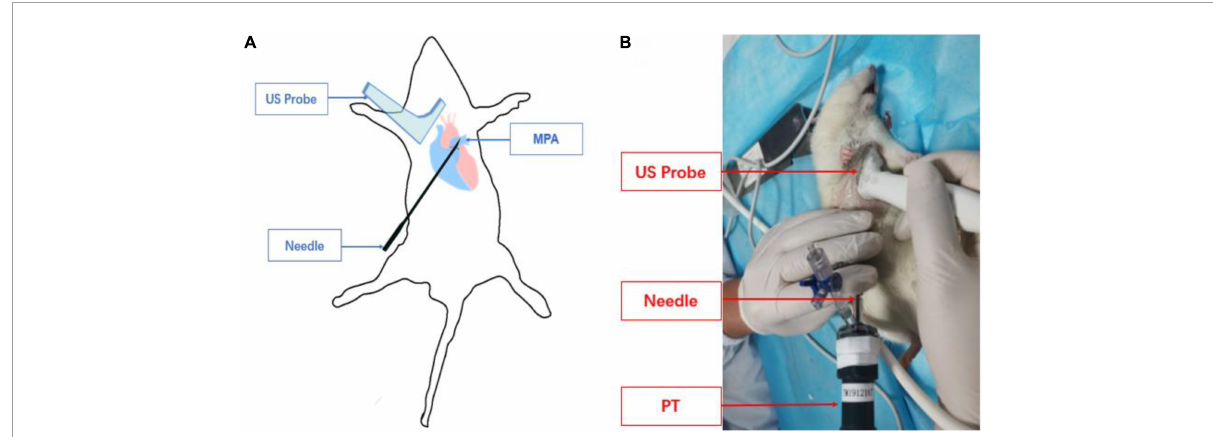
FIGURE2 Schematic diagram of pulmonary artery puncture guided by high-frequency ultrasound. (A) Schematic diagram of needle track and transducer positioning. (B) The actual operation of pulmonary artery puncture is guided by ultrasound.